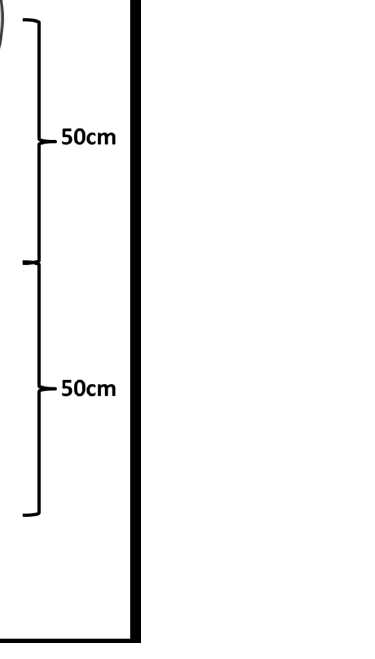
Fig 1. HVL measurement